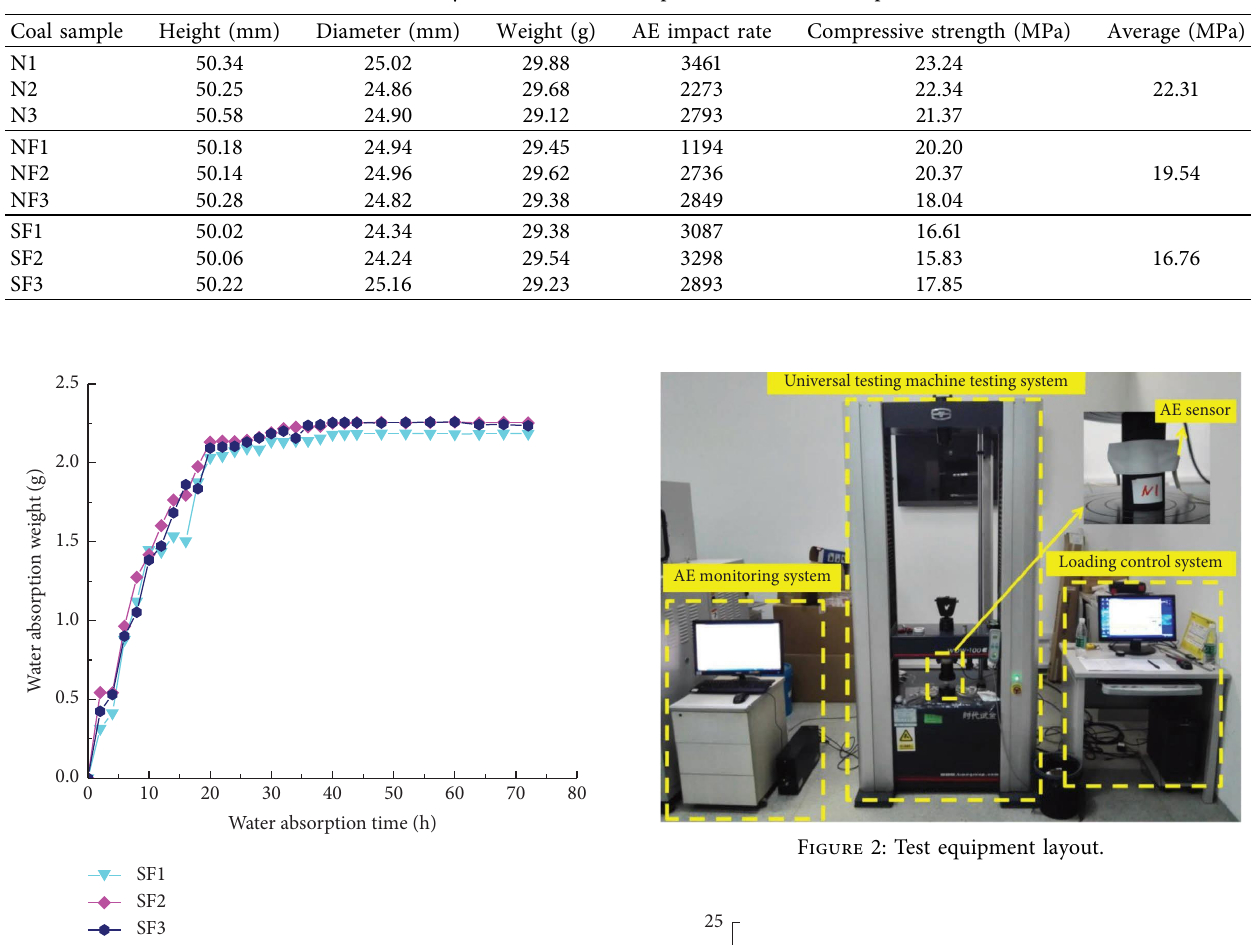
Figure 1: Coal sample water absorption weight-time curve.